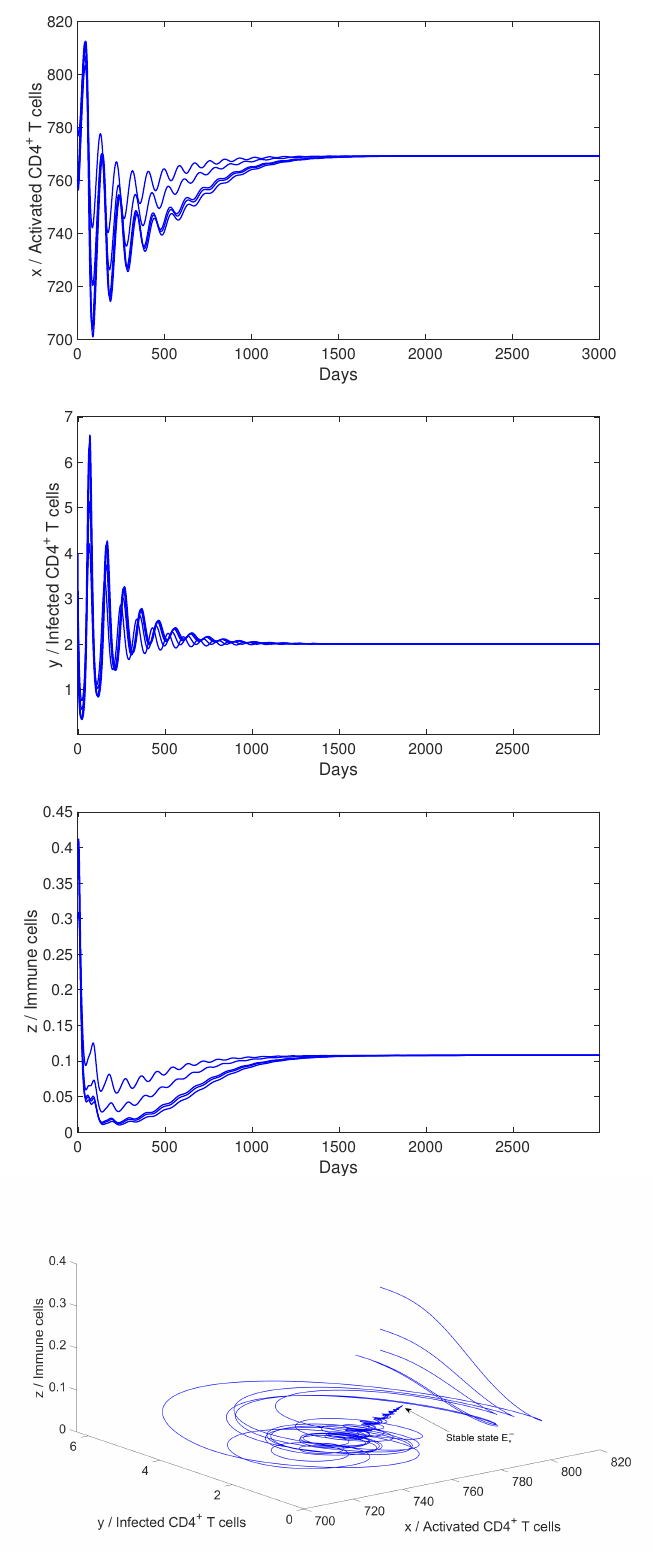
Figure 10. Time histories and trajectories of system (1) with different initial values for c = 0.8 day − 1 . Only E 1 − ∗ is stable. Other parameter values are listed in Table 3 and α =